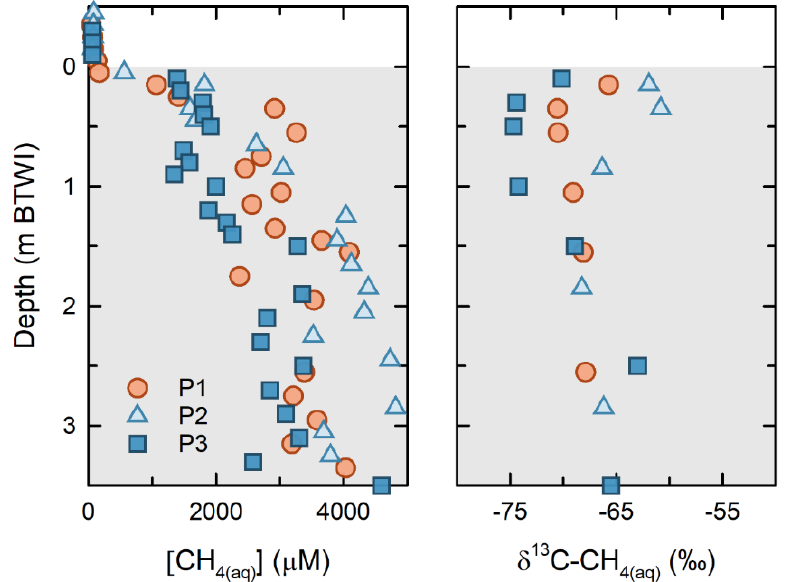
Figure 4. Dissolved methane concentrations ( µ M) and isotopic compositions ( δ 13 C) for FFT porewater in 2016 from P1, P2, and P3 (see sampling site locations on Figure 2).